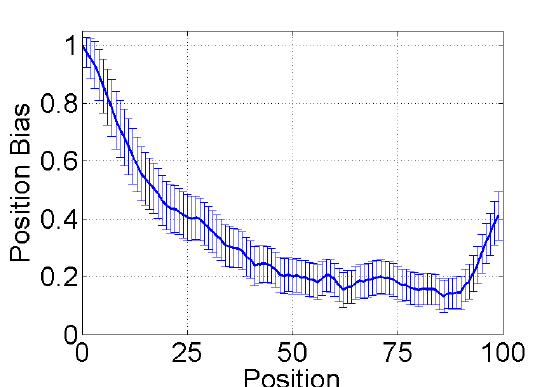
Figure 5. Position bias. The relative decrease in recommendations received by items at different position within a list, compared to expected recommendations. Items in top positions (1–5) receive four to five times as much attention as items in lower positions (50–75). The increase near the end of the list is created by people who start inspecting the list from the end.